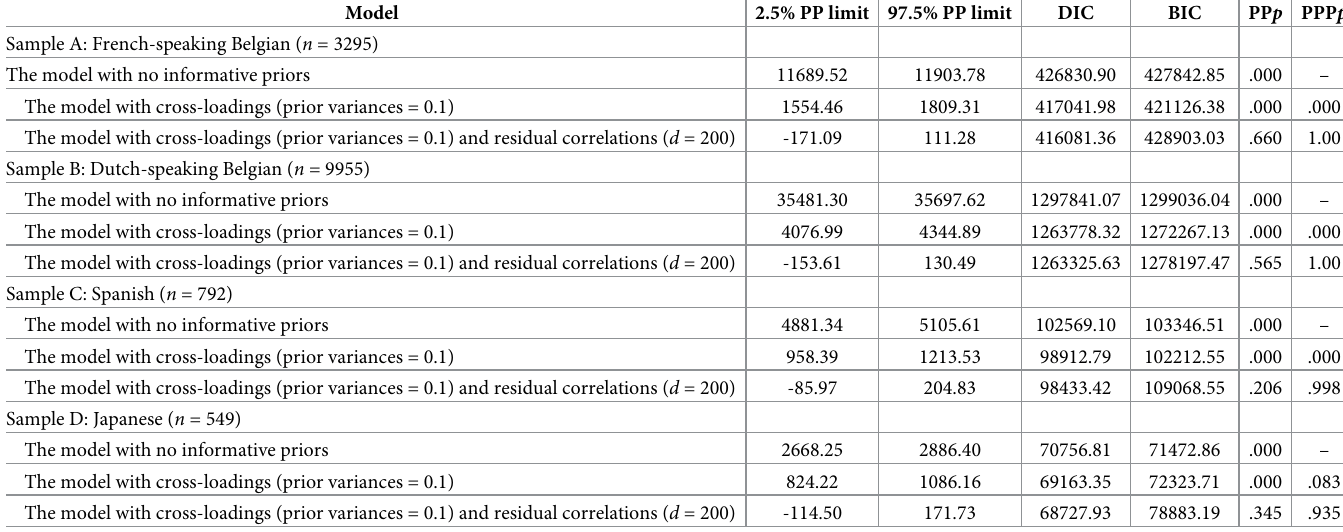
Table 3. Fit indices of Bayesian structural equation modeling of the modified target-based structure